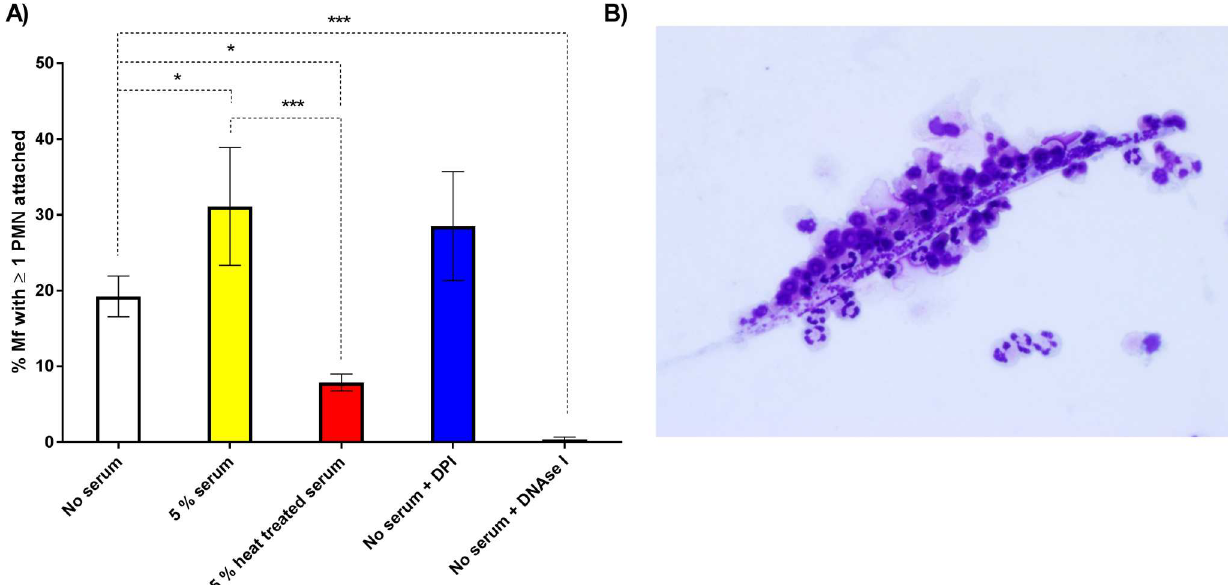
Fig 3. The attachment of PMNs to B . malayi Mf. A: The percentageof Mf that had at least one PMN adheredto their surface or indirectly fastened by extracellular DNA at 24 hours post-experimental set up (n (cid:21) 6). White, yellow, red, blue, and black bars represent no serum, 5% autologousserum, 5% autologousheat-treated (55˚C, 30 mins) serum, 10 μ M diphenyleneiodonium (DPI) and 30 μ g/mlDNase I treated wells respectively.Error bars represent standarderror of the mean; * P < 0.05, ** P < 0.01, *** P < 0.001. B: Image of PMNs adheredto a Mf. Image taken after 24 hours of incubation in 5% autologousserum at 37˚C and 5% CO 2 . The preparation was stainedwith modified Wrights’